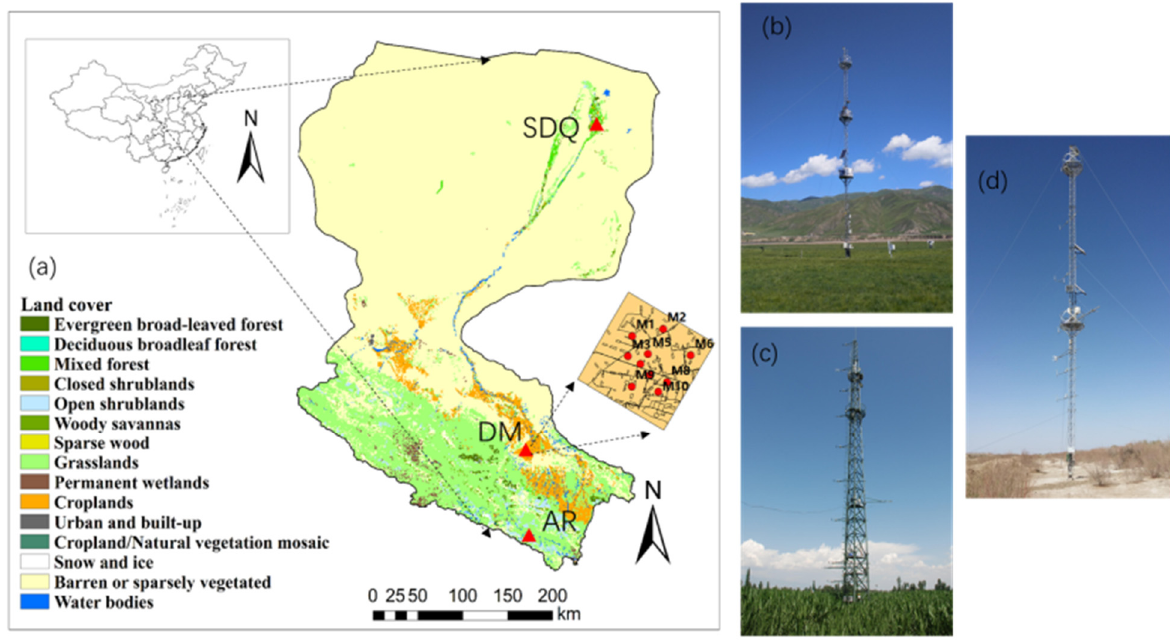
Figure 1. ( a ) Location of the study area of Heihe River Basin in China. Red triangles and circles represent three super stations and ten stations in the middle stream, respectively. ( b – d ) correspond to AR, DM, and SDQ stations, respectively.